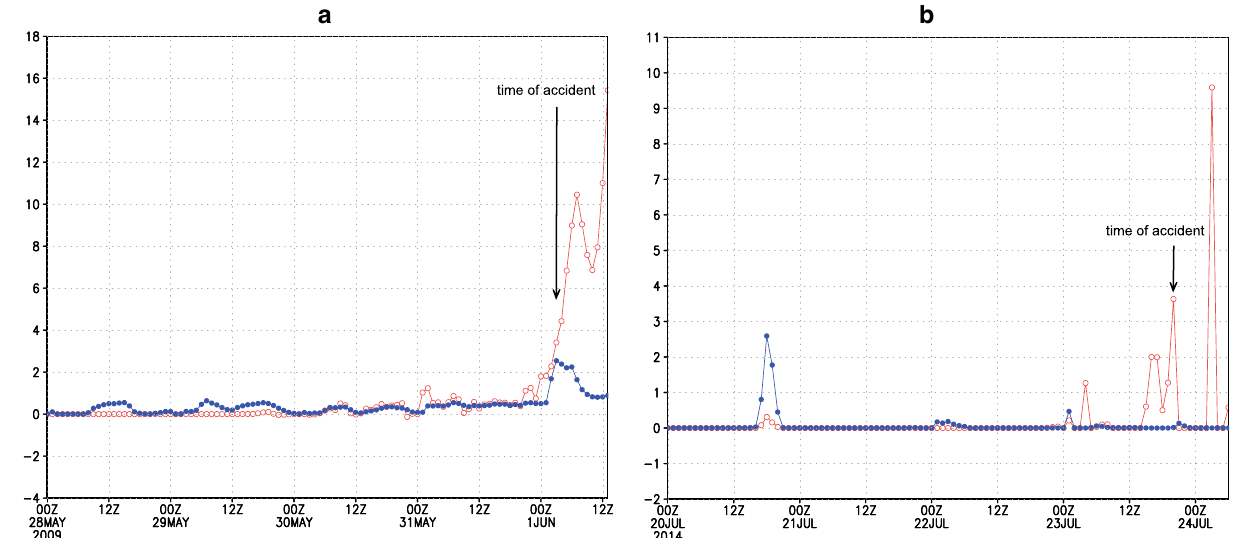
Figure 5. ( A , B ) Time evolution of the ice-nucleating dust particle concentration n INP (red) and the ice concentration n ice (in #/liter) of the Ferrier atmospheric driven microphysical scheme 18 (blue) at flight levels of two considered flights, AF477 (left) and AH5017